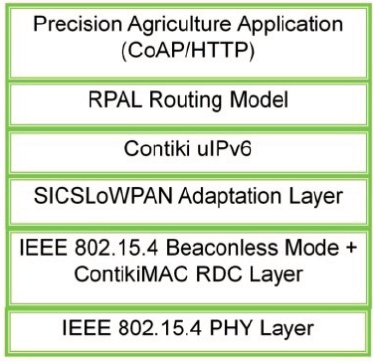
Figure 4. Protocol stack for evaluating the RPAL routing